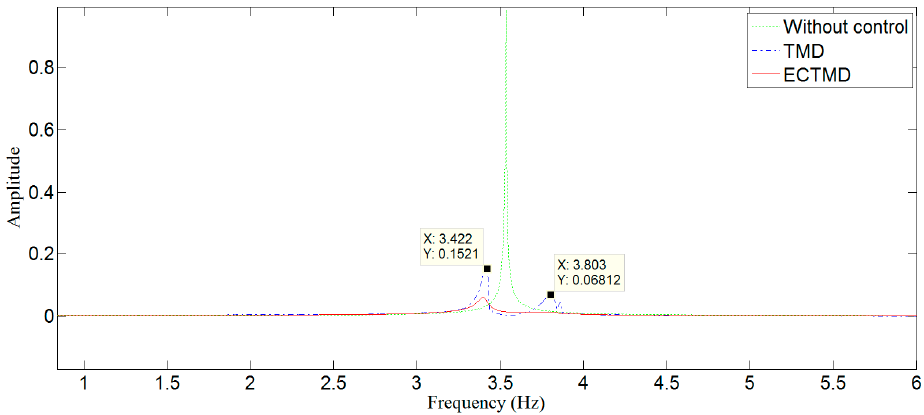
Figure 6. Frequency spectrum of the free vibration response of the cantilever beam in tuned situations.